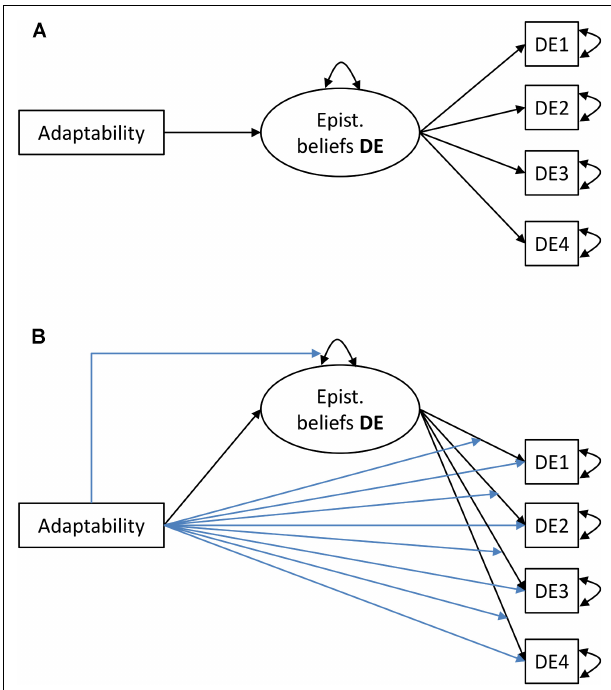
FIGURE 2 | (A) Baseline model with adaptability as covariate that predicts the factor mean; (B) MNLFA model with adaptability as covariate that predicts the factor mean and variance as well as the item loadings and intercepts. DE, Epistemological beliefs in the development of scientific knowledge.